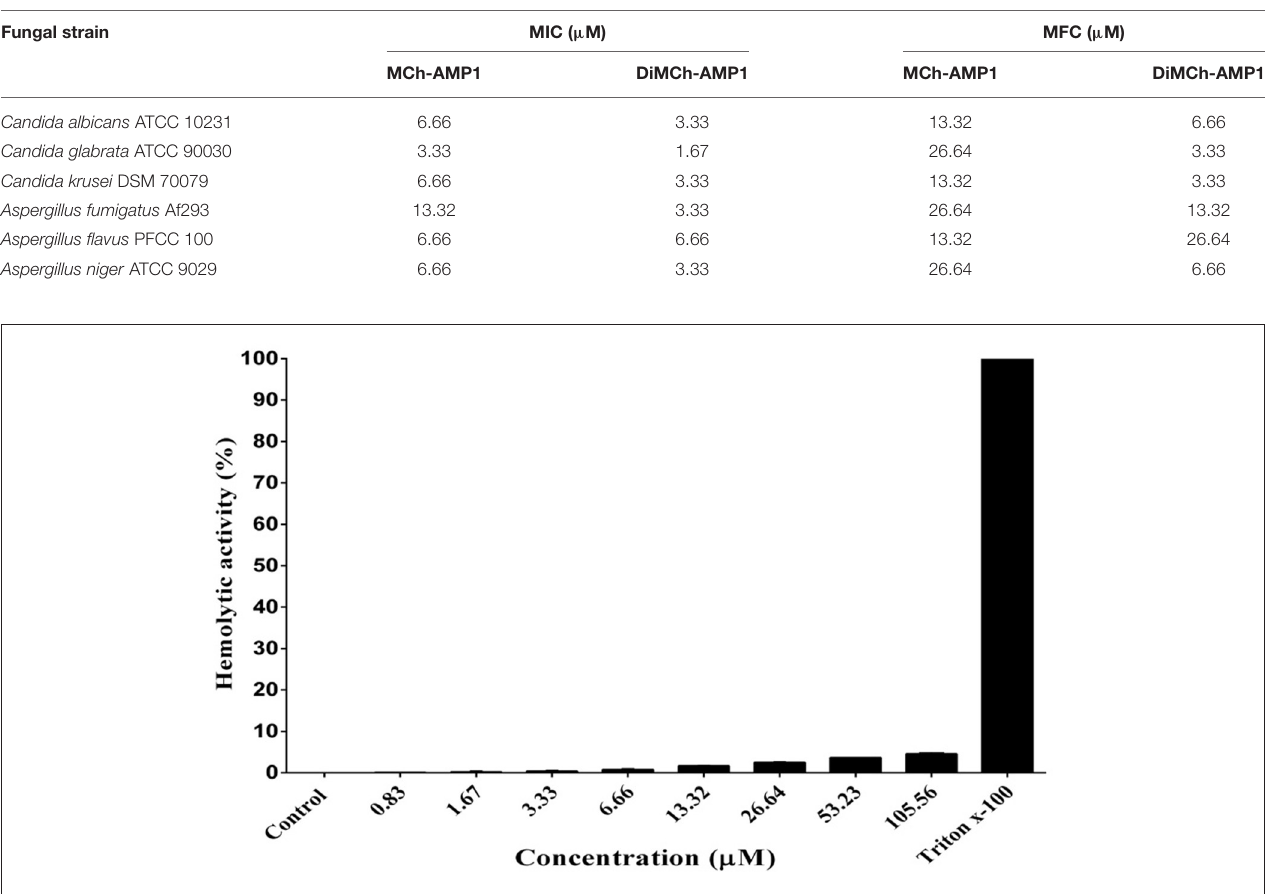
N-terminal pro-peptide expression vector of pET28a( + ), as a fusion encoding His-tag to produce AMPs and purify the